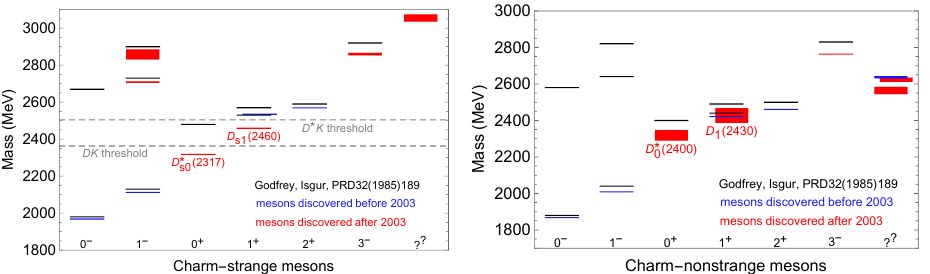
Figure 1. The charm-strange and charm-nonstrange meson mass spectra. The predictions in the GI quark model [14] are shown as in black lines, while the mesons observed before and since 2003 are shown as blue and red lines, respectively. For the observed mesons, the masses given in the RPP [13] are taken, and the bands correspond to their